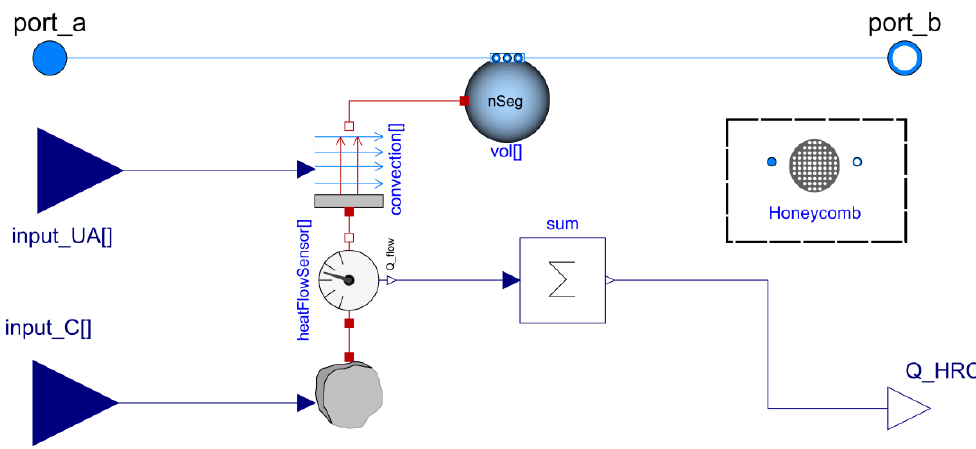
Figure 9. 1D Model in Modelica for the honeycomb heat exchanger.